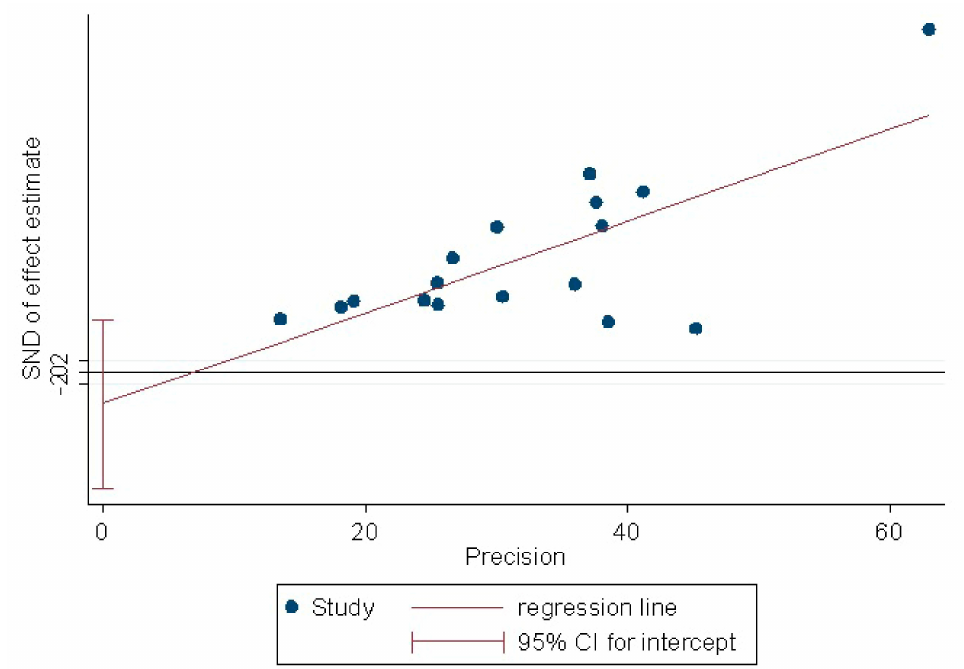
Figure 4. Publication bias as quantitatively assessed performing the Egger’s linear regression test. The finding of the test showed no evidence of publication bias. SND: standard normal